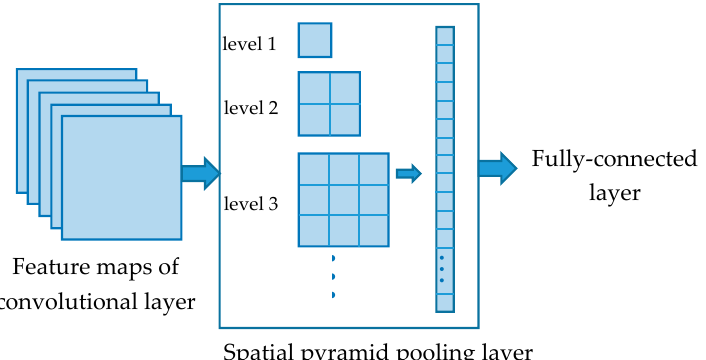
Figure 4. Convolutional neural network (CNN) with a spatial pyramid layer. Each input image is pooled to several levels. The results are transformed into one-dimension vectors to form the spatial pyramid pooling (SPP) output.